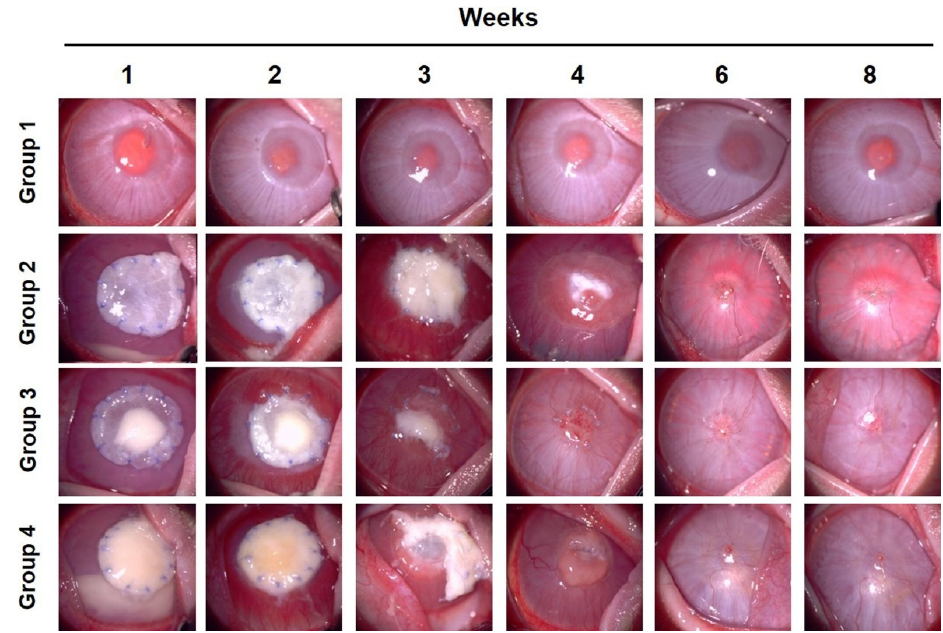
Figure 2. Clinical features of each group. Slit lamp bio-microscopic examination was done from 1 to 8 weeks after surgery. In group 1, angiogenesis was not induced; however, opacity was shown at the surgical site. In groups 2, 3, and 4, angiogenesis was actively induced up to the third week. In group 2, the opacity was noticeably improved from the sixth week, and in group 3, improvement in opacity was shown from week 4. However, in group 4, serious complications, such as descemetocele and inflammation, were seen from the third week.